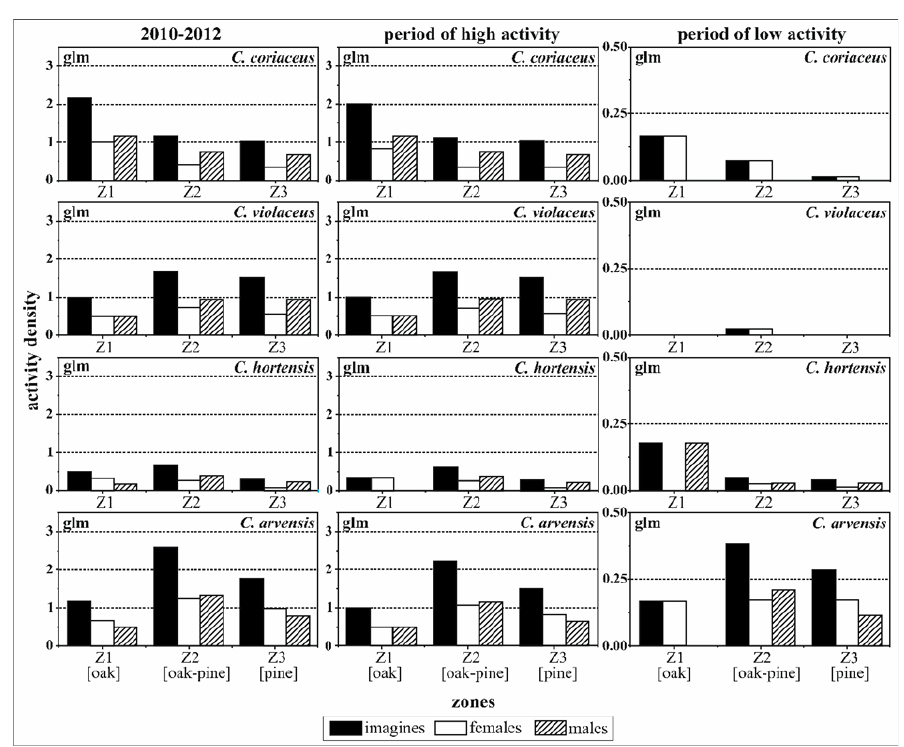
Figure 5. Spatial, zone-related activity densities of imagines, females and males of the four observed Carabus species ( C. coriaceus , C. violaceus , C. hortensis , C. arvensis ) calculated by parameters of the generalised linear model (glm) approach (high activity period: May to September, low activity period: October to April). Table 5. Parameters of interspecific comparisons explained by the generalised linear geostatistical model (glgm) related to the three zones of influence and differentiated by periods of activity. (The significance of results at p -value 0.05 are highlighted by bold font).